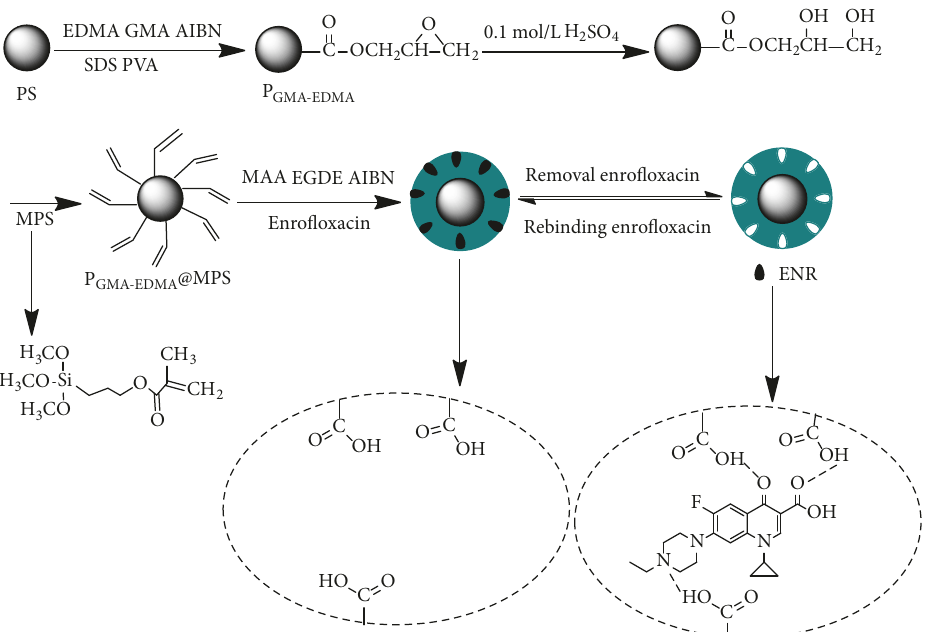
Figure 2: Schematic expression of the reaction process used to prepare P GMA